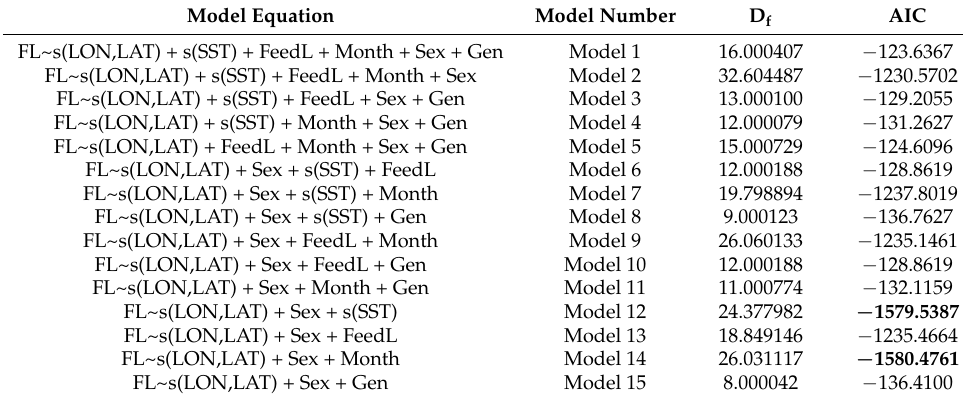
Table 1. Variables included in the GAM formulations and their performance results.